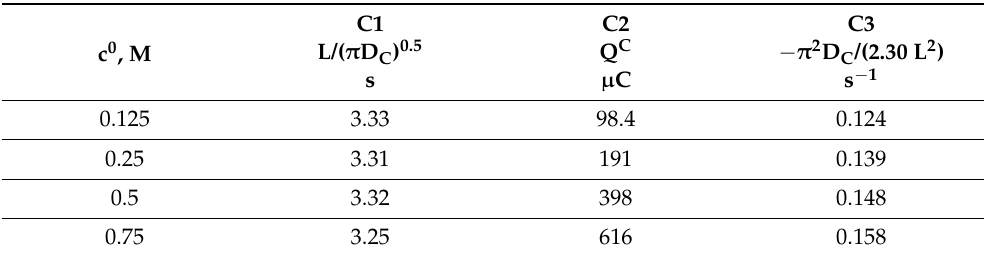
Table 3. Results of various procedures, C1 to C3, for the treatment of experimental current transients for the Br 2 reduction (Figure 5a).